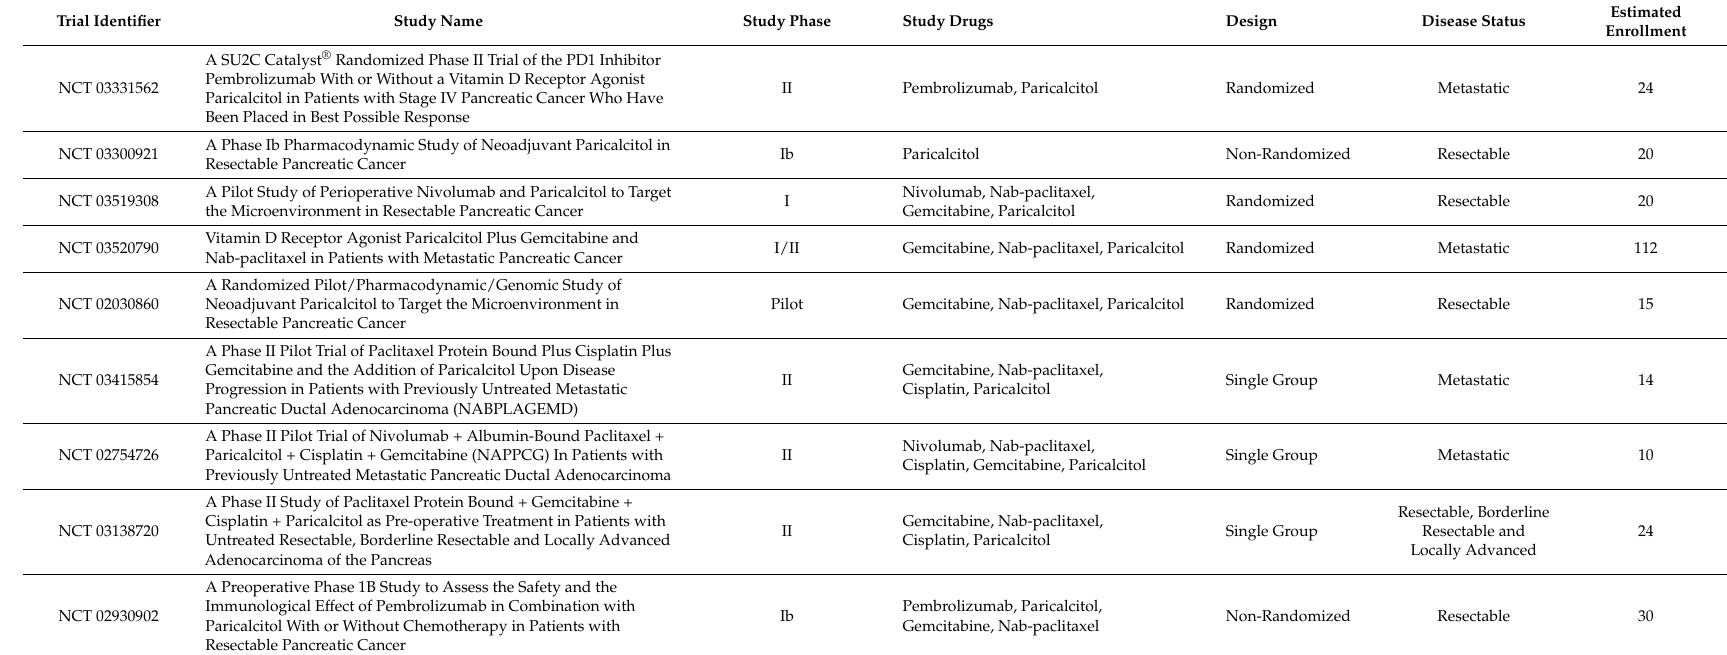
Table 1. Key pancreatic cancer clinical trials employing Vitamin D